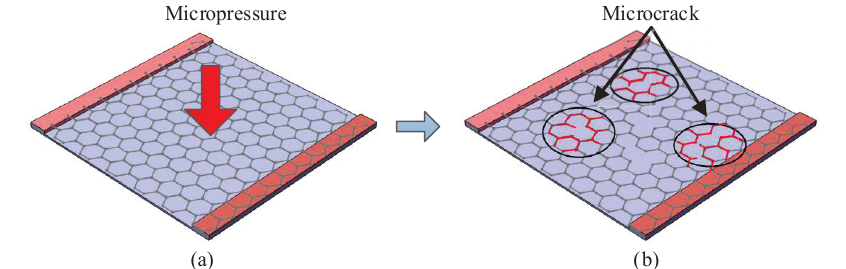
Figure 1. Schematic diagram of the working principle of the sensing unit. ( a ) Morphology of graphene thin films before being subjected to micropressure; ( b ) Microstructure of graphene film under